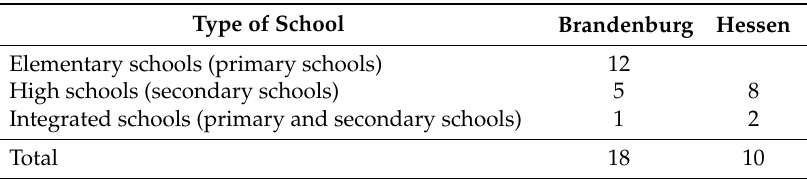
Table 1. Type of schools included in